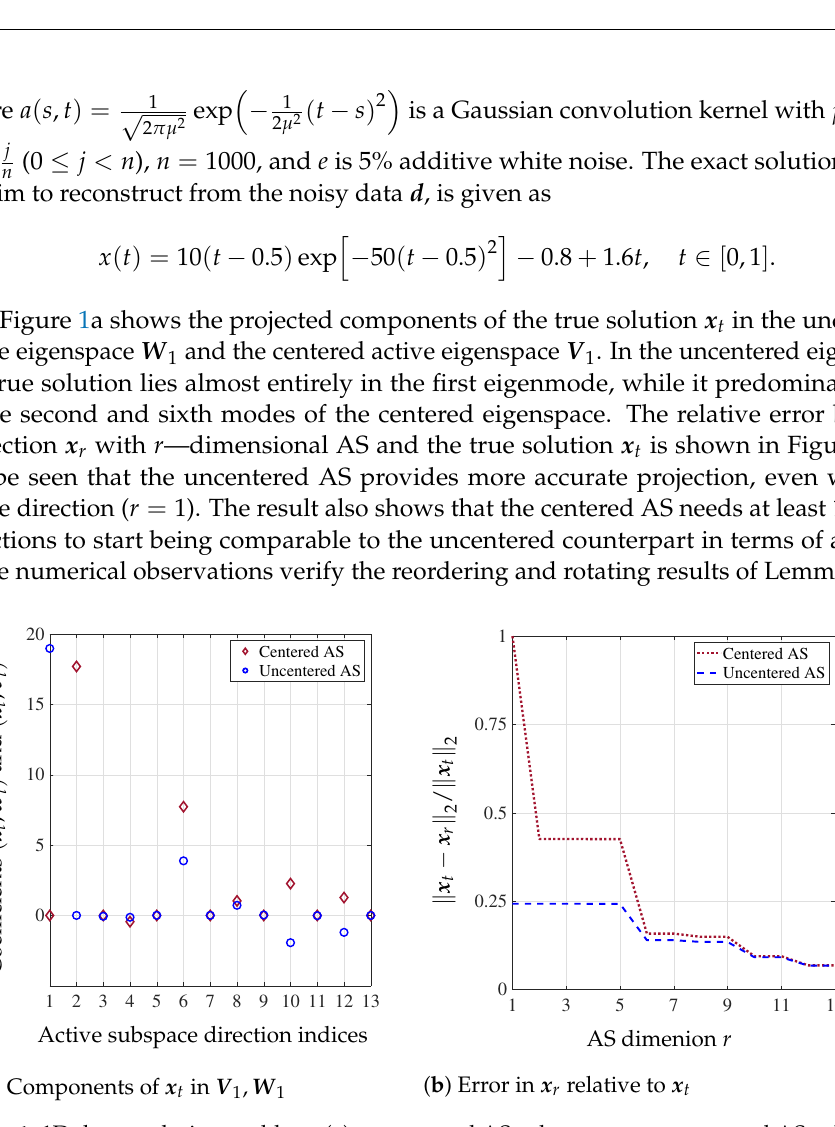
Figure 1. 1D deconvolution problem. ( a ): uncentered AS subspace versus centered AS subspace in representing the true solution. ( b ): relative error of DIAS-A and TSVD solutions as a function of active subspace dimension r